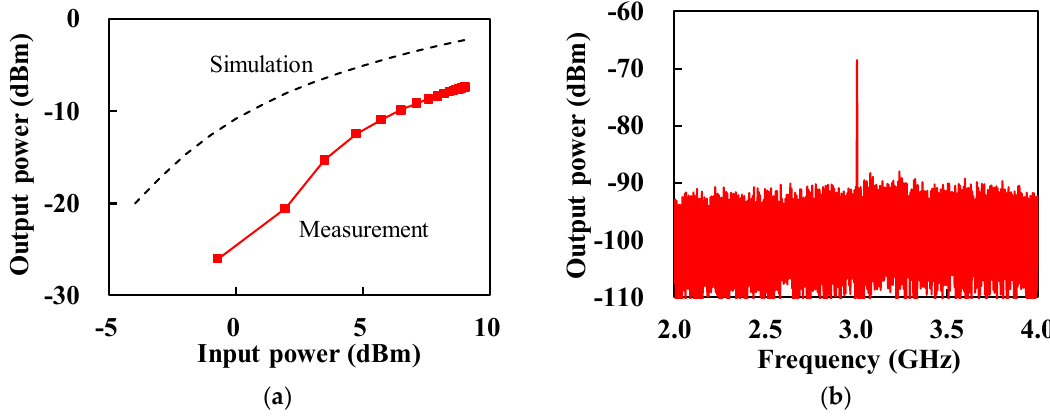
Figure 6. Measured output power and conversion gain of the frequency tripler at an input power around 9.6 dBm.